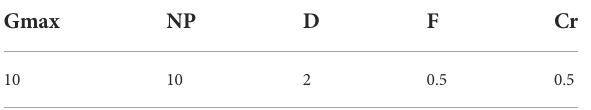
TABLE 2 The parameters of the